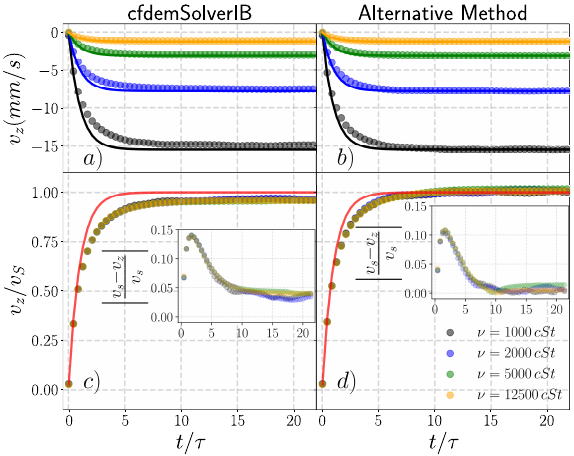
Figure 2. a) and b) Time evolution of the settling velocity of the sphere for both methods. c) and d) Time evolution of the settling velocity scaled by the corresponding Stokesian terminal veloc- ity. The insets represent the relative di ff erences in each case. Note that a more accurate asymptotic limit velocity is reached in our method. All solid lines represent the expected